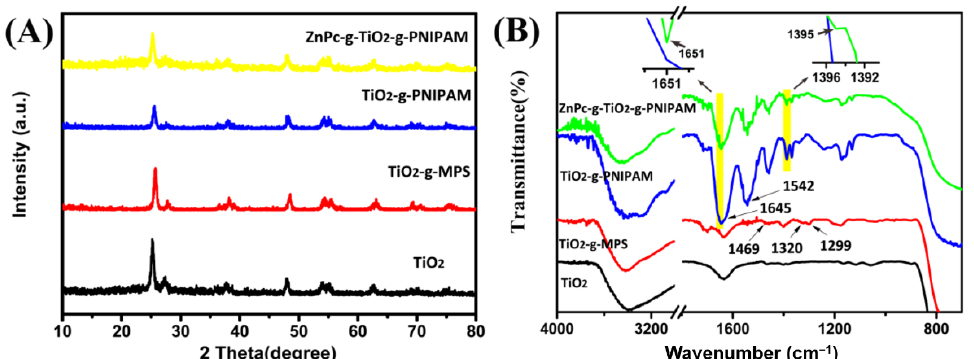
Figure 1. XRD patterns ( A ) and FT-IR spectra ( B ) of TiO 2 , TiO 2 -g- MPS, TiO 2 -g- PNIPAM and ZnPc - g- TiO 2 -g- PNIPAM.